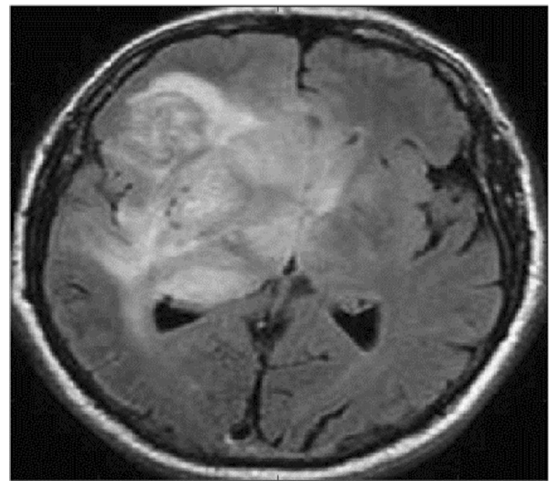
Fig. 3 The result of the 1st processing stage